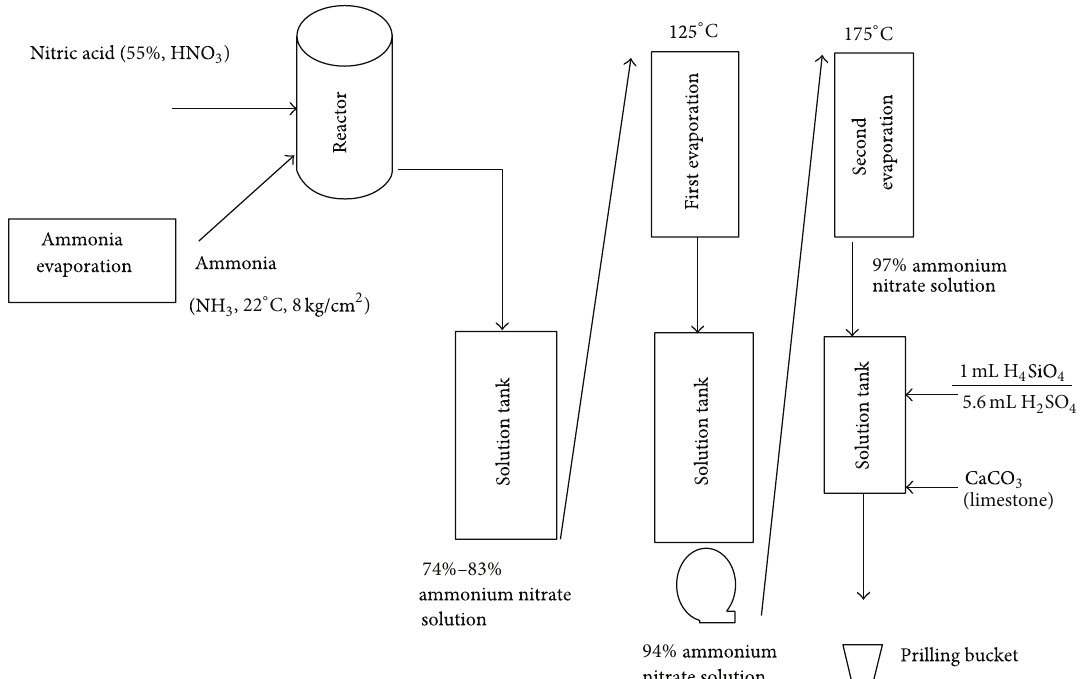
Figure 1: Process diagram for ammonium nitrate